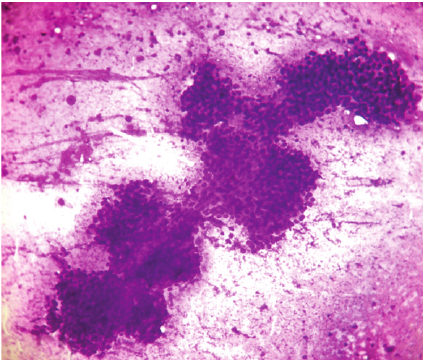
Figure 2: FNA cytosmears from inguinal lymph node showing round to oval tumor cells arranged in papillary structures; background shows many lymphocytes and eosinophilic proteinaceous material (Leishman, × 100).